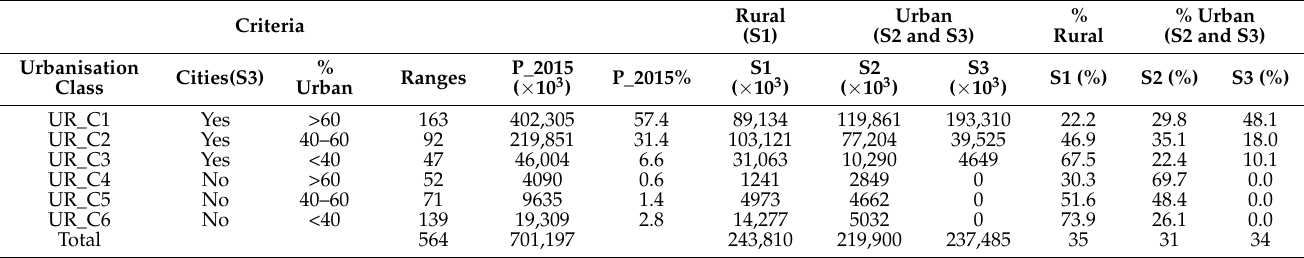
Urban % Urban (S1) (S2 and S3) (S2 and S3)